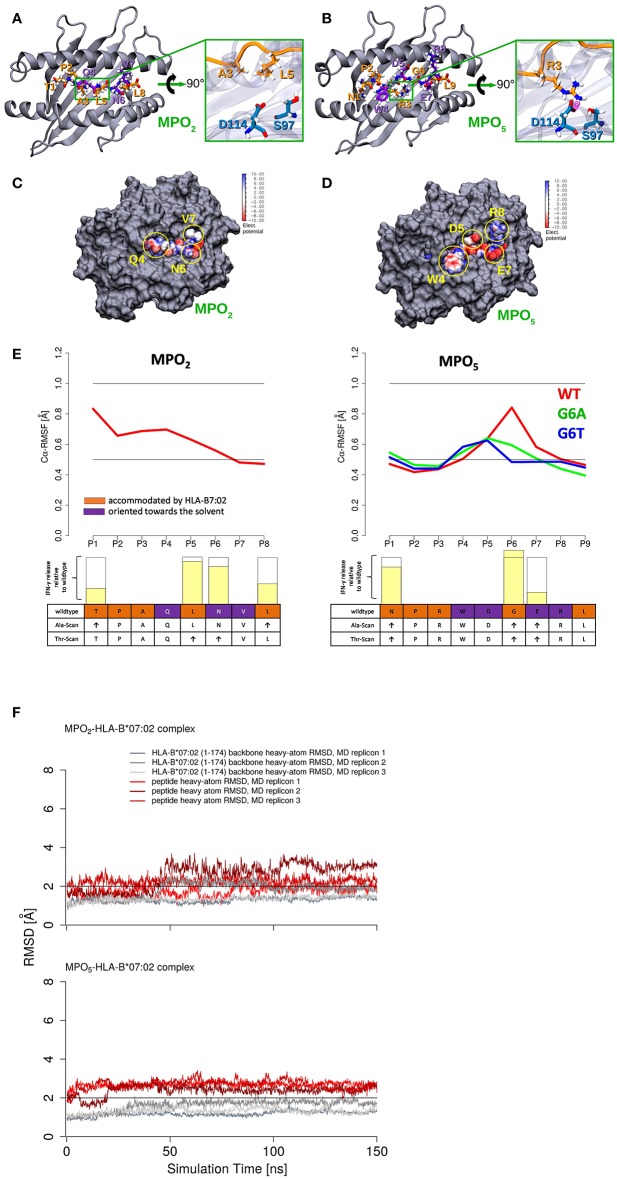
MPO2/5-HLA-B7 structure-based modeling revealed less fluctuation of MPO5 within the HLA-binding cleft compared to MPO2. (A,B) Representative conformation of MPO2/5 in the bound state. The HLA-B7 protein is shown as cartoon representation (gray), the bound peptides are depicted in stick representation and are highlighted: (hydrogen atoms: white, nitrogen atoms: blue, oxygen atoms: red, carbon atoms: orange or violet), solvent-exposed peptide residues (violet carbon atoms), peptide residues accommodated by the MHC peptide binding cleft (orange carbon atoms). In the green inlays, the HLA-B7 residues S97 and D114 (blue sticks) are shown for a direct comparison of major differences in the MPO2/5 HLA-B7 binding modes and anchoring to the HLA-B7 peptide binding cleft. Peptide backbones are shown in orange cartoon representation. (A) The green inlay depicts the MPO2 residues A3 and L5, accommodated by the MHC peptide binding cleft. (B) The green inlay depicts the MPO5 residue R3. Hydrogen bonds are highlighted in magenta. (C,D) Space filling models showing the TCR interface of the MPO2/5-HLA-B7 complexes. Protein is depicted in gray and the bound peptides are depicted as van der Waals (vdW) surface colored according to their electrostatic potential (white: neutral areas, red: negatively charged areas, blue: positively charged areas). Solvent-exposed and TCRF5.4- or TCR2.5D6-accessible residues of the MPO2/5-HLA-B7 complexes are highlighted with yellow circles, respectively. (E) Calculated root mean square fluctuations (RMSF) of Cα atoms of the HLA-B7-bound MPO2/5 peptides (red) and G6A (green)/G6T (blue) variants of MPO5 (average of three independent MD simulations). The individual TCR-recognition motif from the alanine- and threonine- (Ala/Thr)-scans is shown together with the IFN-γ release (transparent yellow bars) observed in the Ala- or Thr-scan (Supplementary Figures 1J,K) relative to individual wildtype IFN-γ secretion (empty bars) below the RMSF plots. The height of the empty bars reflects the maximal IFN-γ release elicited by the wildtype peptide, ↑ = interchangeable amino acid residues. The Ala/Thr-scan for MPO5 is described elsewhere (27). (F) Root mean square deviation (RMSD) of HLA-B7 protein backbone heavy atoms and MPO2/5 heavy atoms during MD simulations calculated with respect to the initial energy minimized peptide-HLA-B7 complex models.